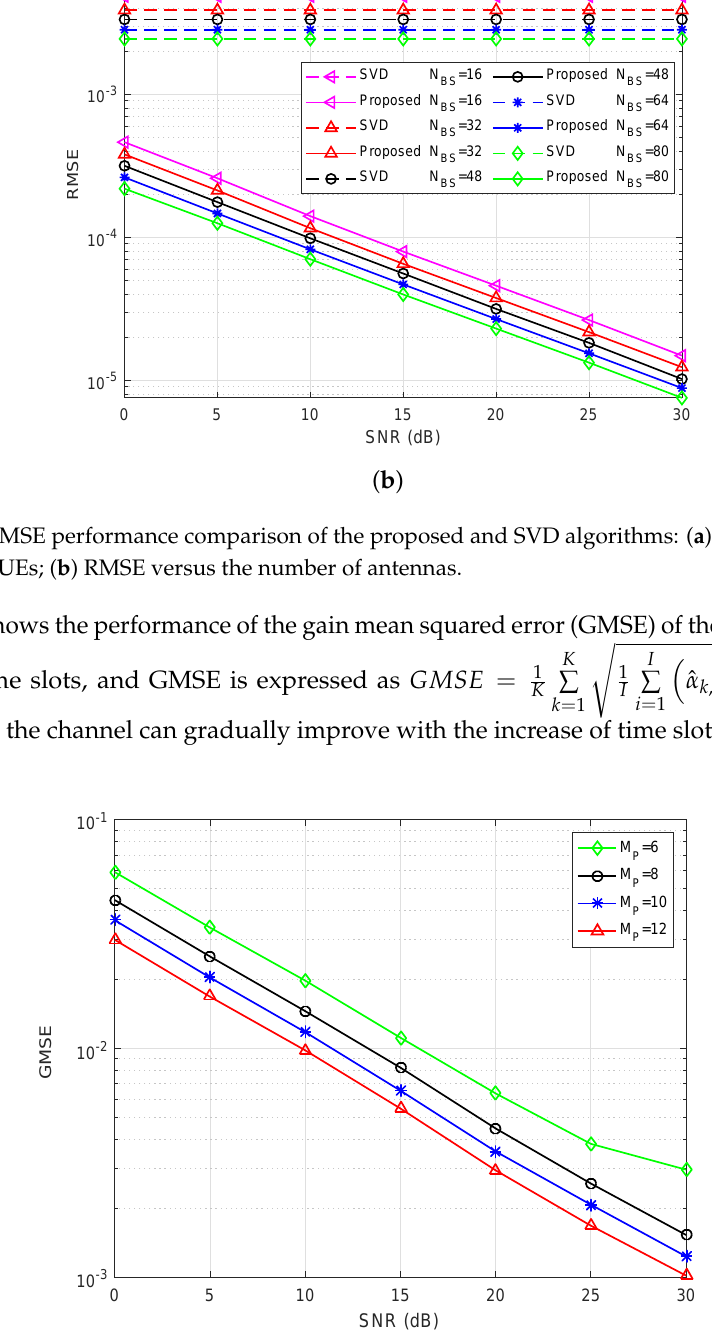
Figure 7. GMSE performance of the proposed algorithm with different time